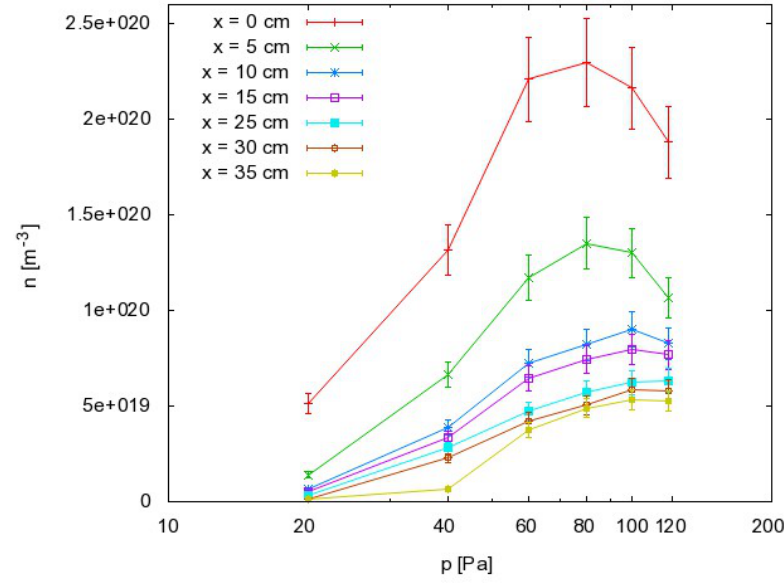
Figure 5. Oxygen atom density versus pressure at different positions in the afterglow chamber. Relative error is around ≈ 10% due to the temperature measurement error and probe physical characteristics measurement error (surface area, mass).